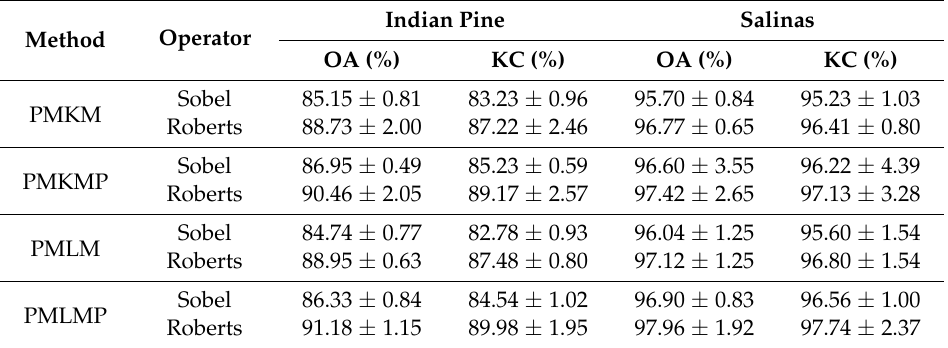
Table 5. Comparison results of using the Roberts cross operator and Sobel filter in our proposal.